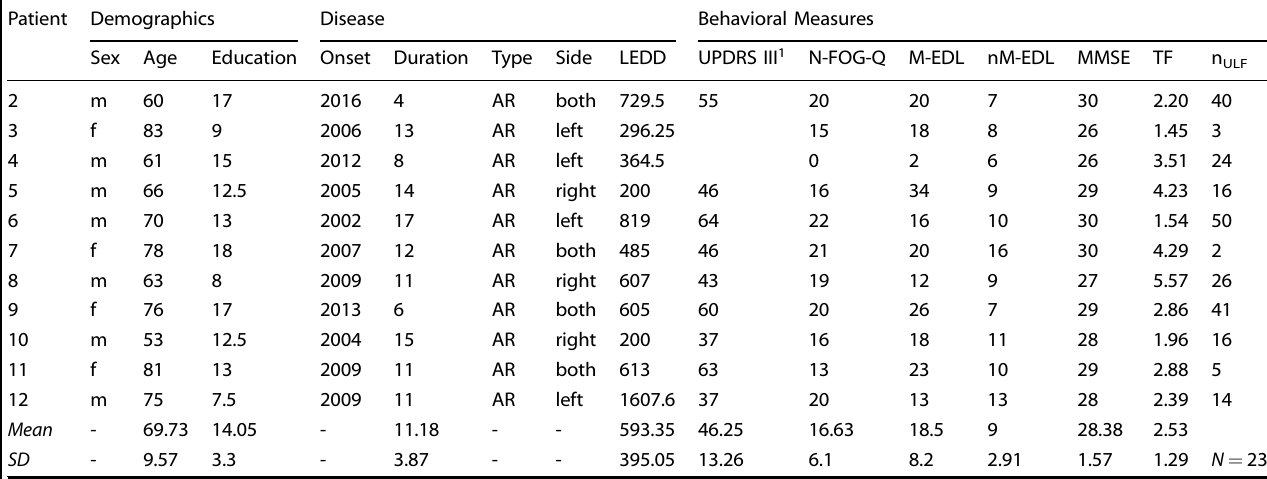
Table 1. Clinical characteristics of the patient cohort.